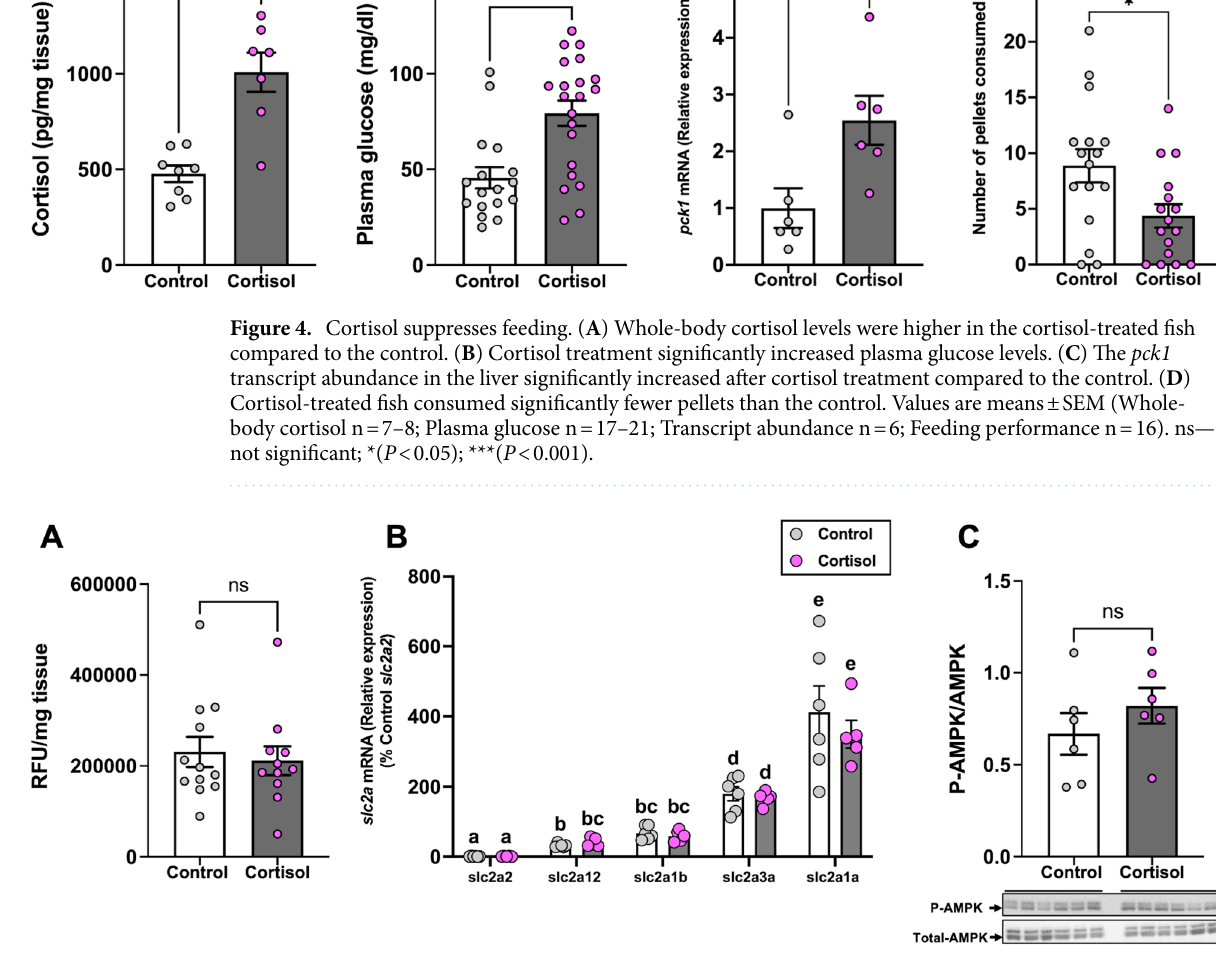
Figure 5. Cortisol does not affect brain glucose uptake. ( A ) Uptake of the fluorescent glucose analogue 2-NBDG in the brain of the cortisol-treated fish remained unchanged compared to the control. ( B ) The transcript levels of the glucose transporters ( slc2a ’s) in the brain did not change after cortisol exposure. ( C ) Cortisol treatment did not change the ratio of phosphorylated to total AMPK (M.W.:62 kDa) in the brain. Values are means ± SEM (Relative fluorescence units; RFU n = 11–12; Transcript abundance n = 5–6; AMPK expression n = 6). ns—not significant; Bars with different letters are significantly different (one-way ANOVA; P ≤